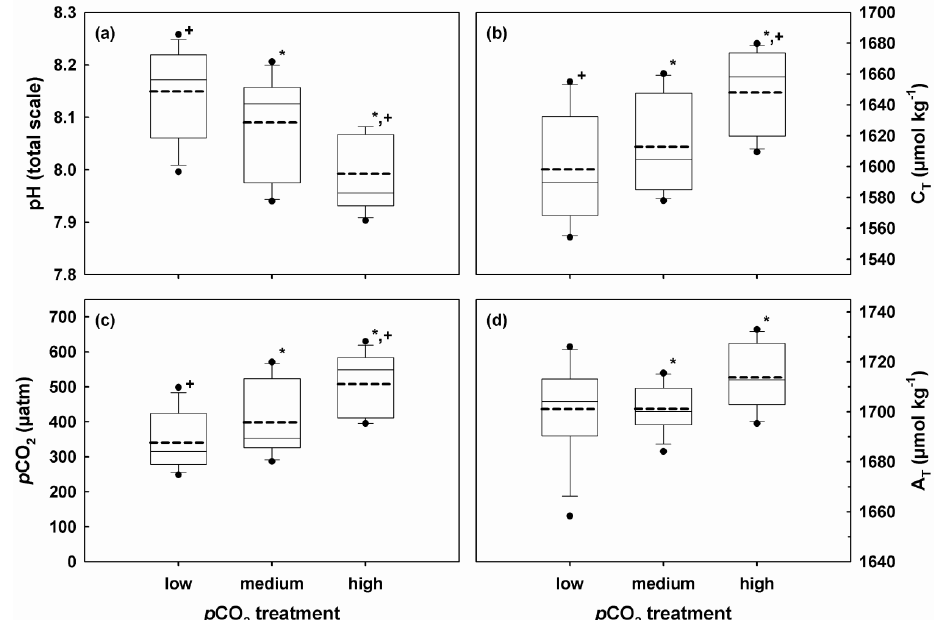
Fig. 1. Box plot ( n = 12) of the carbonate system for three CO 2 treatments (low, medium, high). Range of the measured values: (a) pH, (b) C T , and of the calculated values: (c) p CO 2 , (d) A T . The box plots show the range from the start to the end of the experiment (showing each outlier). Solid lines represent the median. Dashed lines represent the mean value. Statistically significant differences are highlighted using symbols: (#) between the low and the medium, (*) between the medium and the high, and ( + ) between the low and the high p CO 2 treatment. Values used are according to Wannicke et al. (2012, Table 1).